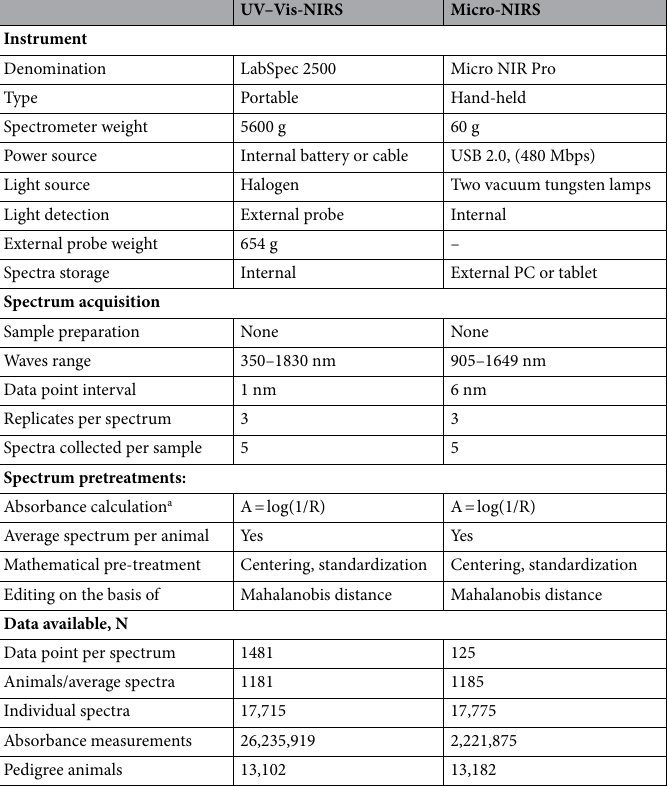
Table 2. Main characteristics of the spectrometers used for predicting quality traits of beef and data